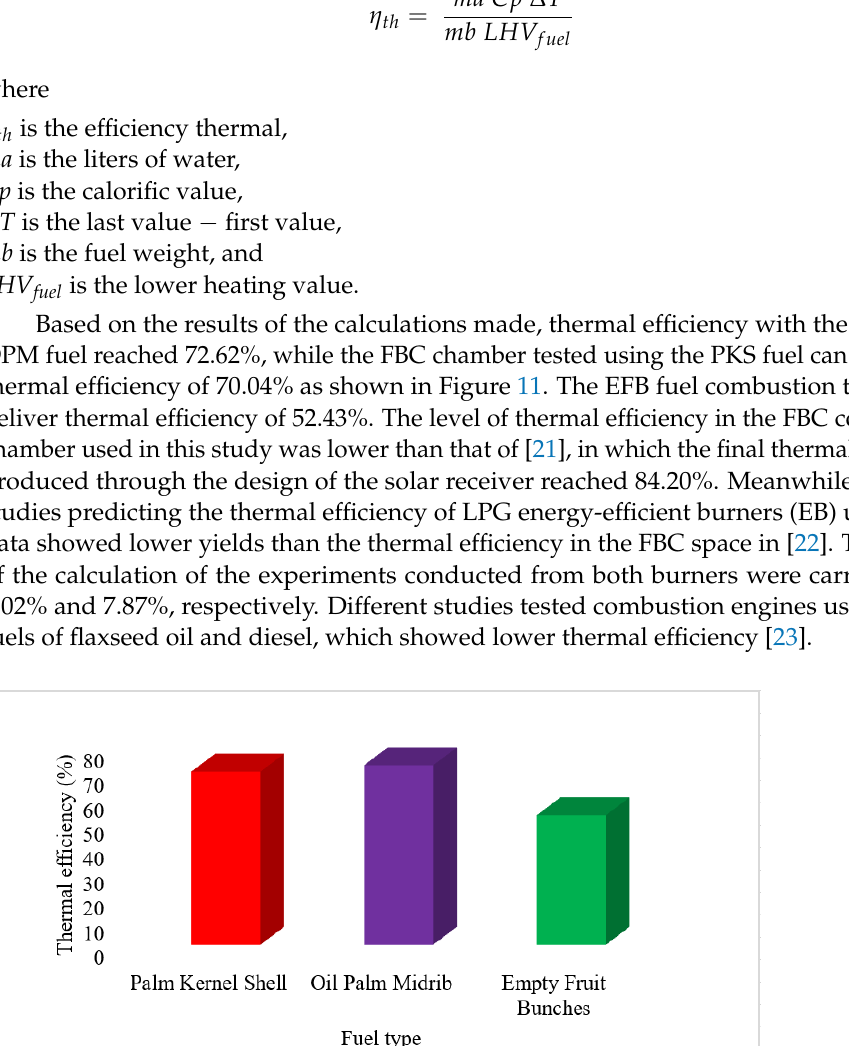
Figure 10. Furnace efficiency in the FBC for different fuels.